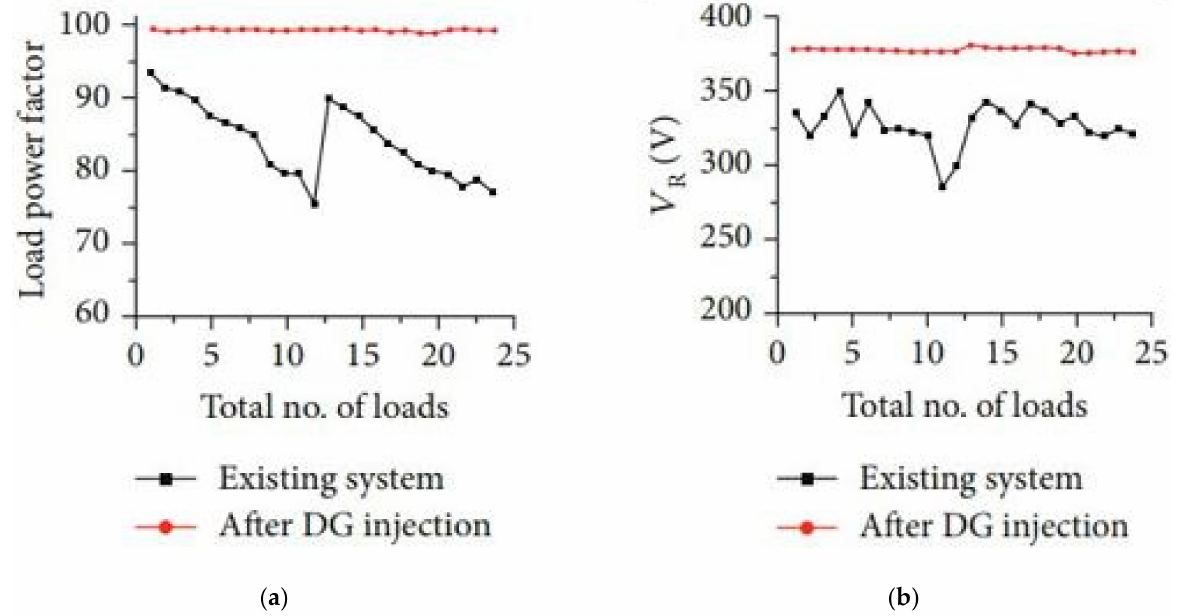
Figure 15. ( a ) Power factor and ( b ) voltage before and after DG injection